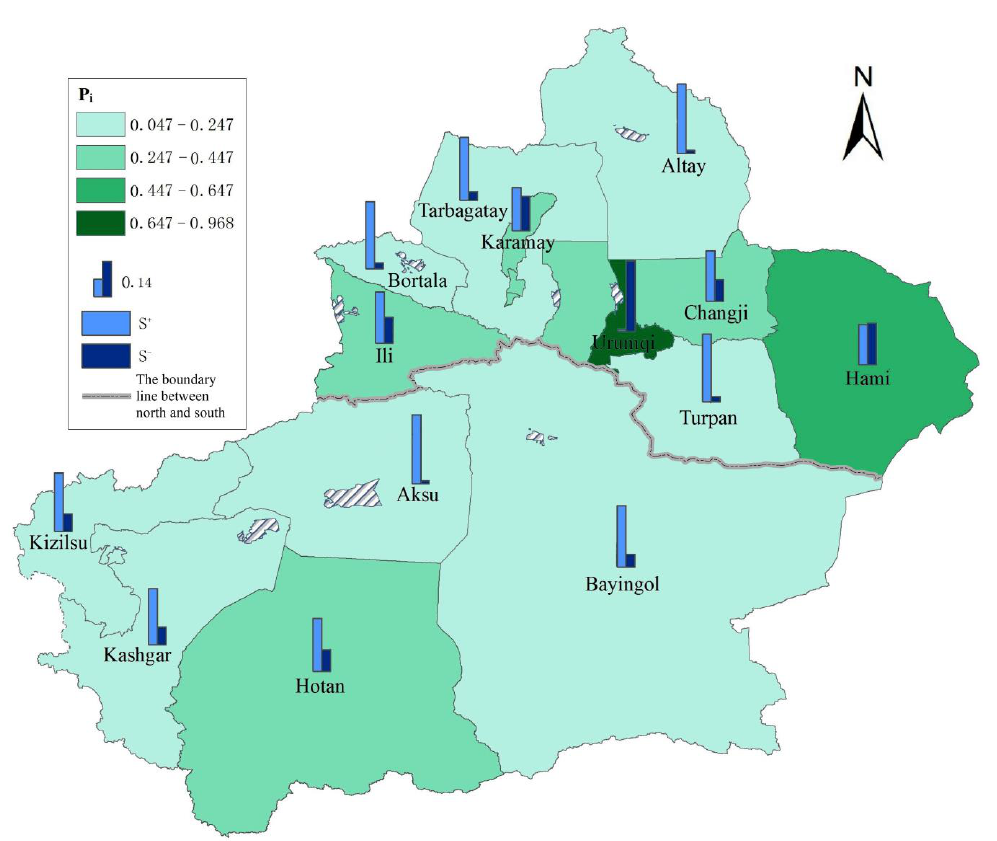
Figure A4. Spatial distribution of 𝑆 + , 𝑆 − and 𝑃 𝑖 .